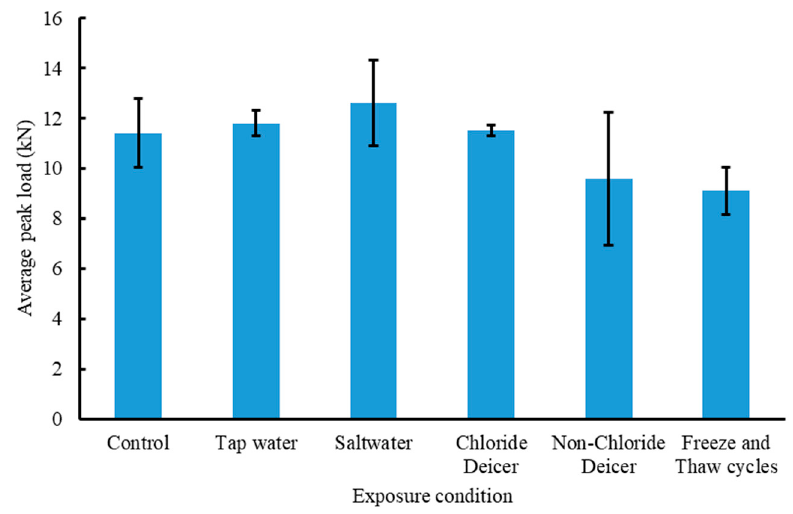
Figure 16. Comparisons between the average peak loads of each group with error bars.